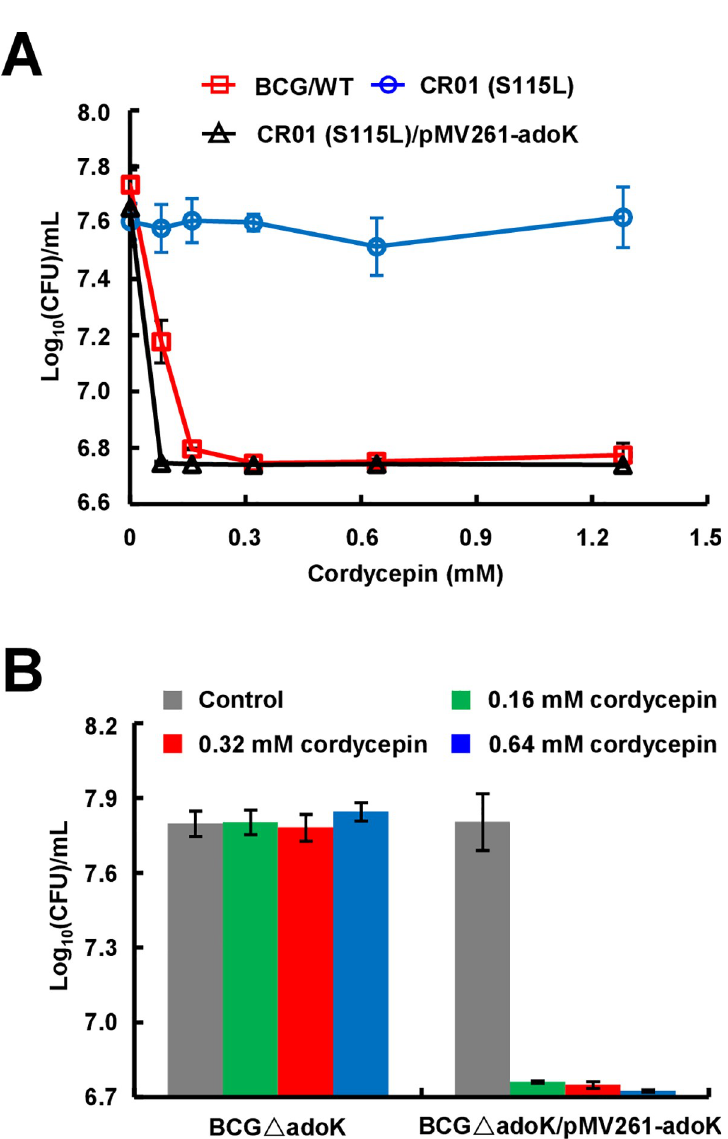
Fig 2. AdoK is responsible for mycobacterial sensitivity to cordycepin. (A) Mutant strain CR01-S115L is resistant to cordycepin. Mycobacterial strains were grown in 7H9 medium containing 0, 0.08, 0.16, 0.32, 0.64, or 1.28 mM cordycepin at 37˚C for 9 days. Their CFUs were then determined and indicated in the figure. Both wildtype BCG/WT and the complemented strain CR01-S115L/pMV261- adoK are sensitive to cordycepin. (B) Assays for the sensitivities of adoK -deleted and its complemented strains to cordycepin. The mycobacterial strains were grown in 7H9 medium containing 0 (control), 0.16, 0.32, and 0.64 mM cordycepin at 37˚C for 9 days, and CFUs were measured. All error bars in the figures represent the standard deviations (SD) of the data derived from three biological